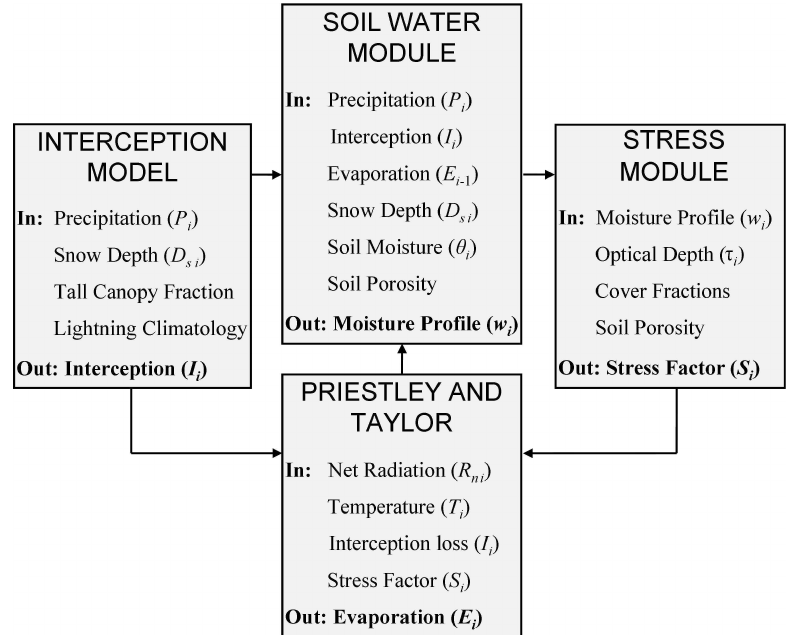
Fig. 1. Schematic overview of GLEAM for a given day ( i ).